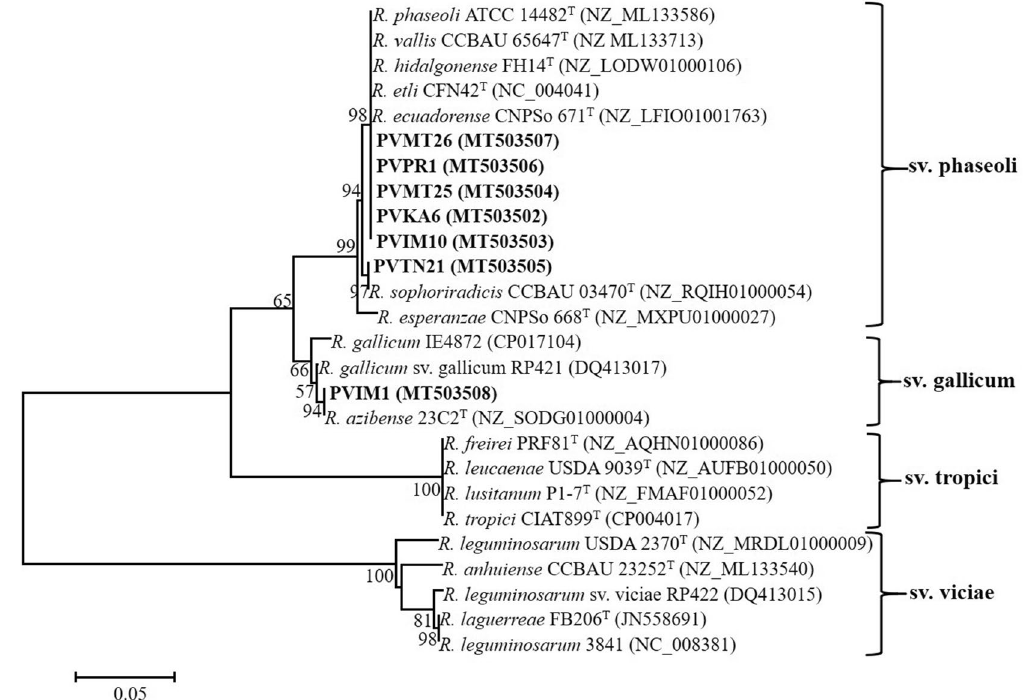
Figure 4. Maximum likelihood phylogenetic trees based on 726-bp alignment of nifH nucleotide sequences. The taxonomic relationships of the studied strains and the closest type strains of Rhizobium species are shown. Strains isolated in the present study are shown in boldface and their accession numbers are given in Supplementary Table S2. Type strains are indicated by superscript “T” and GenBank accession numbers of their sequences are indicated within parentheses. Bootstrap values (greater than 50%) were calculated for 500 replications and are shown at the nodes. The scale bar shows the number of nucleotide substitutions per site. Phylogenetic analysis was conducted in MEGA 6 104 (https:// www. megas oftwa re. net/) using the maximum likelihood algorithm with the Tamura 3-parameter model plus Gamma rate distribution (T92 + G). The genus names are abbreviated as follows: R. ,